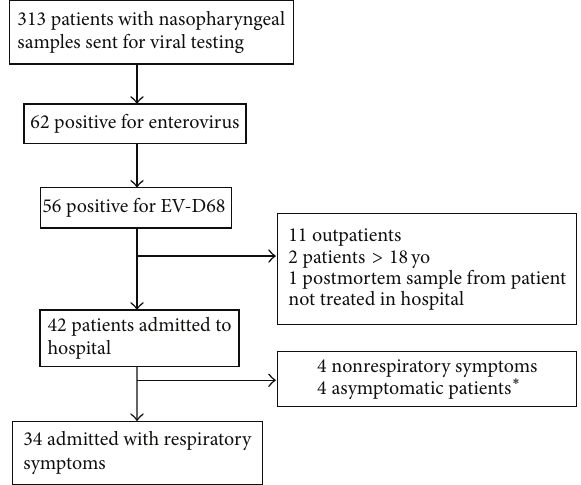
Figure 1: Flowchart of participants. ∗ 3 patients had swabs as part of a presurgical assessment and 1 patient was to start chemotherapy and had a swab because of remote viral